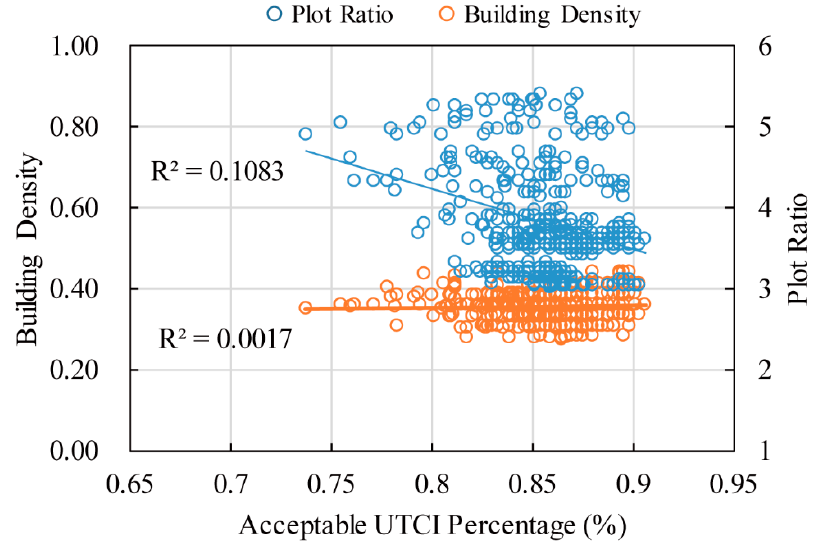
Figure 15. The percentage of building form distribution with optimization of higher than 85% of acceptable UTCI percentage at street level.